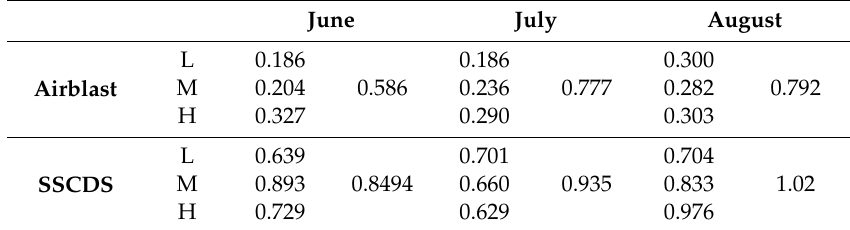
Figure 6. Least square means of deposition of tartrazine dye ( µ g / cm 2 ). Means shown for each of the sampled dates ( A ) 5 / 2 / 16, ( B ) 6 / 8 / 16, ( C ) 7 / 12 / 16, and ( D ) 8 / 8 / 16 and heights (L = 0.7 m, M = 1.4 m, H = 2.1 m). Error bars indicate (Tukey-Kramer) 95% confidence intervals. Di ff erent letters within a month indicate significant di ff erences among bars within a month. No significant di ff erences were detected in May and June. Table 5. Coe ffi cient of Variation of deposition ( µ g / cm 2 ) for each date and height. Least square mean of each treatment, height, and date combination on the left and least square mean of the overall date and treatment combination to the